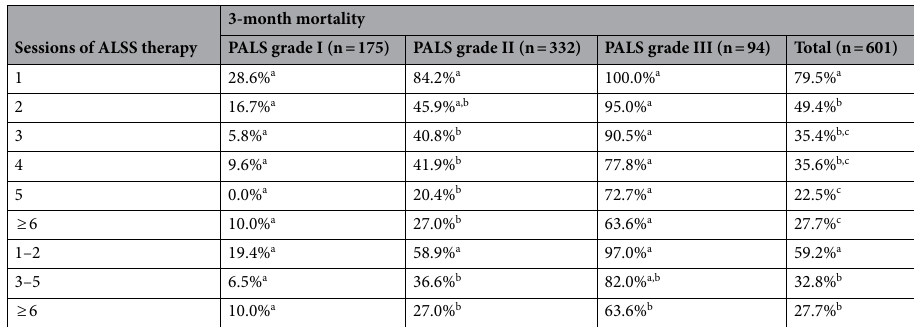
Sessions of ALSS